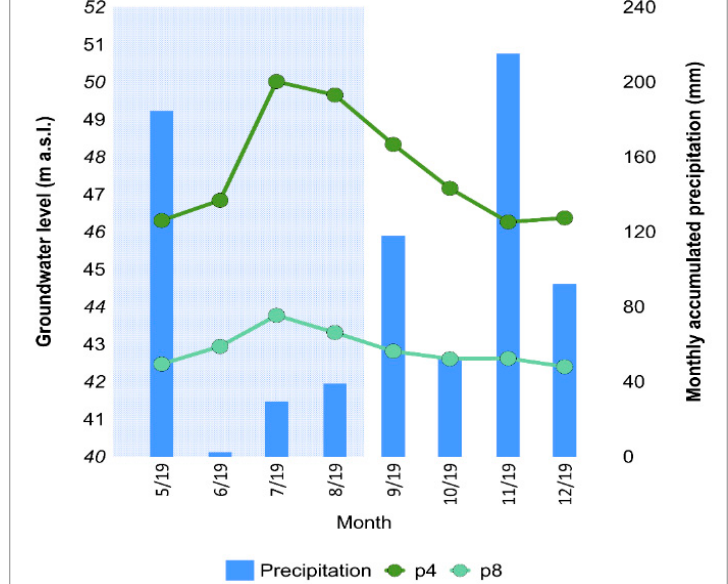
Figure 6. Groundwater level fluctuations in wells p4 and p8 (markers with straight lines) and monthly precipitation from the Goito meteorological station (bars). The shaded area includes the irrigation period.